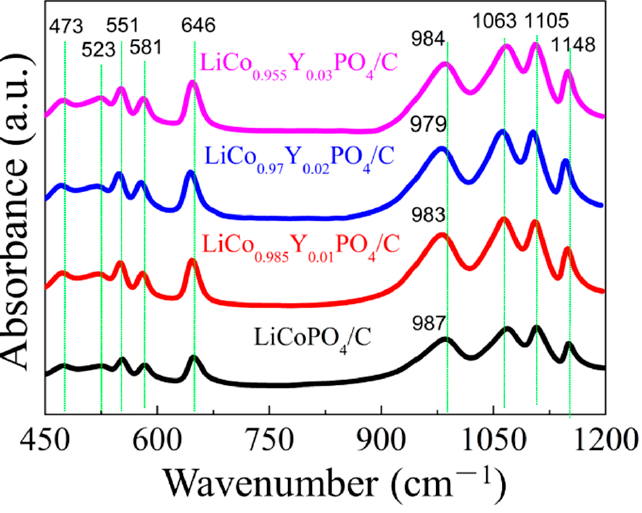
Figure 5. FTIR spectra of the four cathode materials.